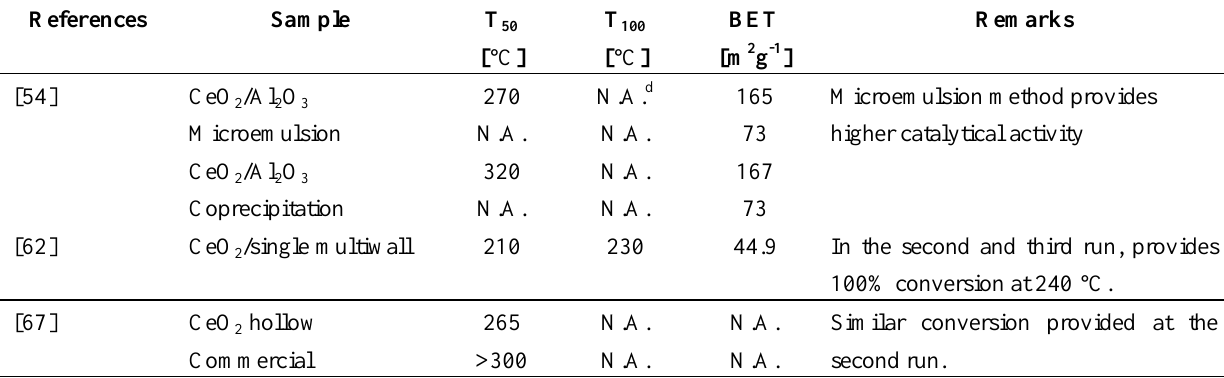
Table 2. Carbon-monoxide oxidation effect on several ceria